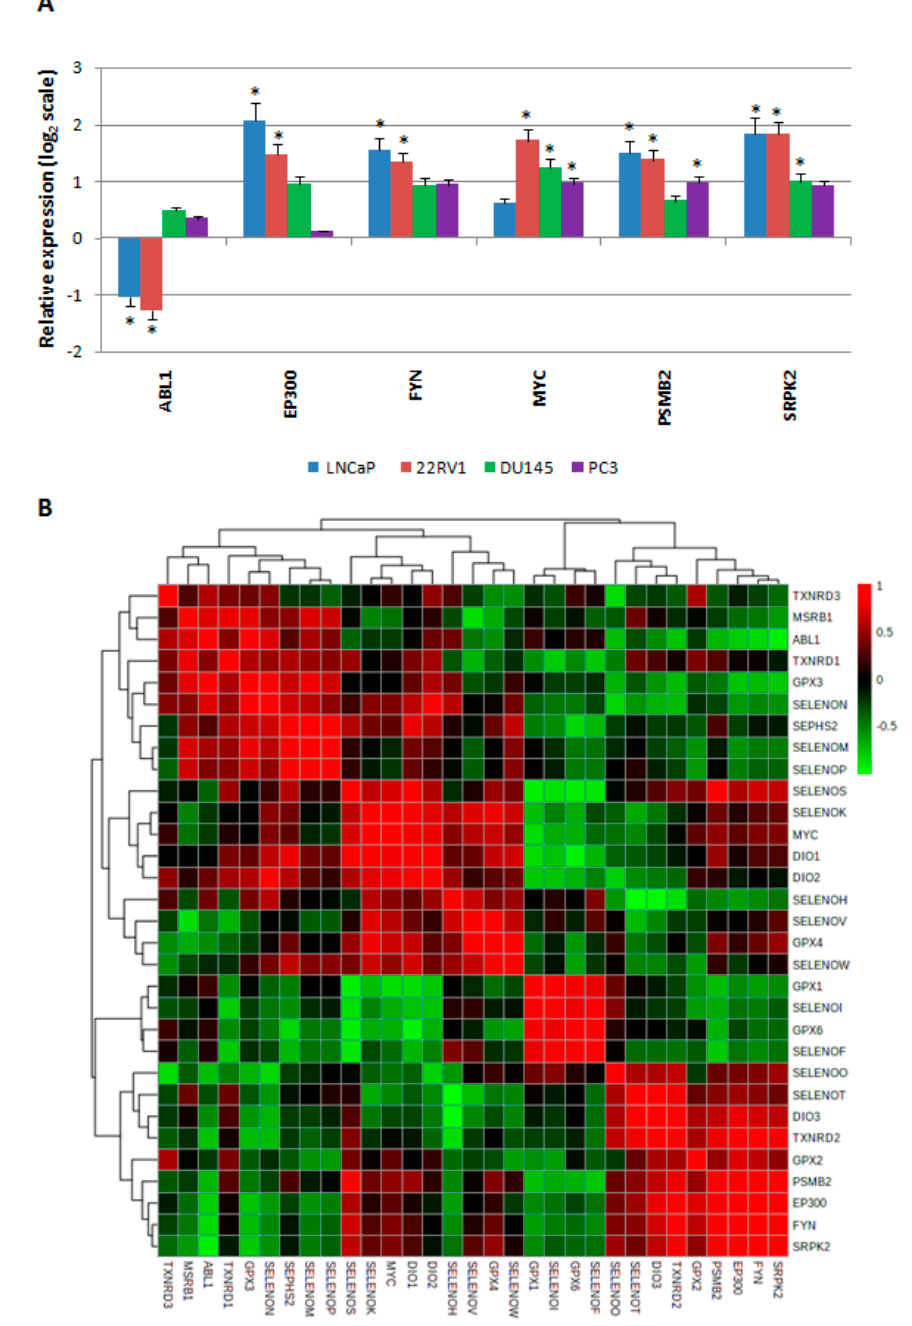
Figure 5. Evaluation of the gene expression levels of HUB nodes in five prostate cell lines and their correlation with the gene expression profiles of the selenoproteins. ( A ) Fold change of gene expression levels for each HUB node, in two androgen receptor-positive (LNCaP and 22RV1), and in two androgen receptor-negative (DU145 and PC3) prostate cancer line cells, compared to the non-cancerous EPN cells, as evaluated by the 2 − ∆∆ Cq method and reported as the log 2 scale. We considered values higher and lower than + 1 and − 1 to be statistically significant, respectively. The statistically significant p -values at < 0.05 are indicated by *. ( B ) Pearson correlation matrix evaluated on the gene expression profiles of the selenoproteins and HUB nodes, evaluated for EPN and prostate cancer cells. Color scale, from red to green color, indicates from good to poor correlations between the gene expression levels of the analyzed proteins.